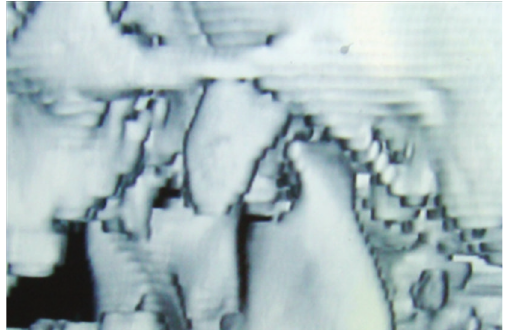
Figure 4: Computed tomography-lateral view.